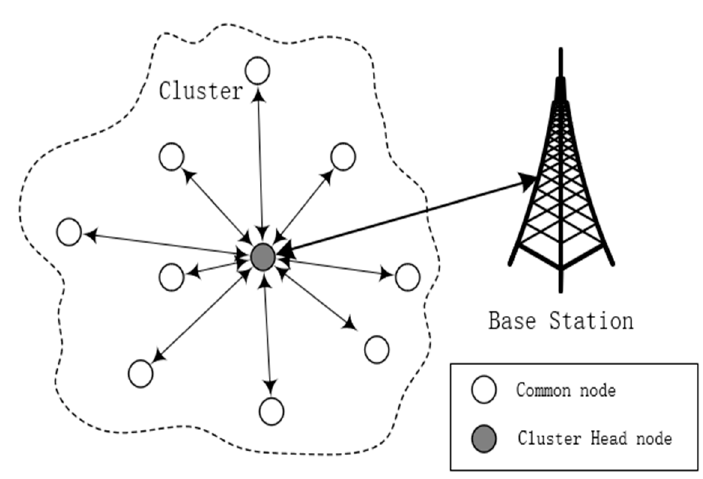
Figure 1. Network model.